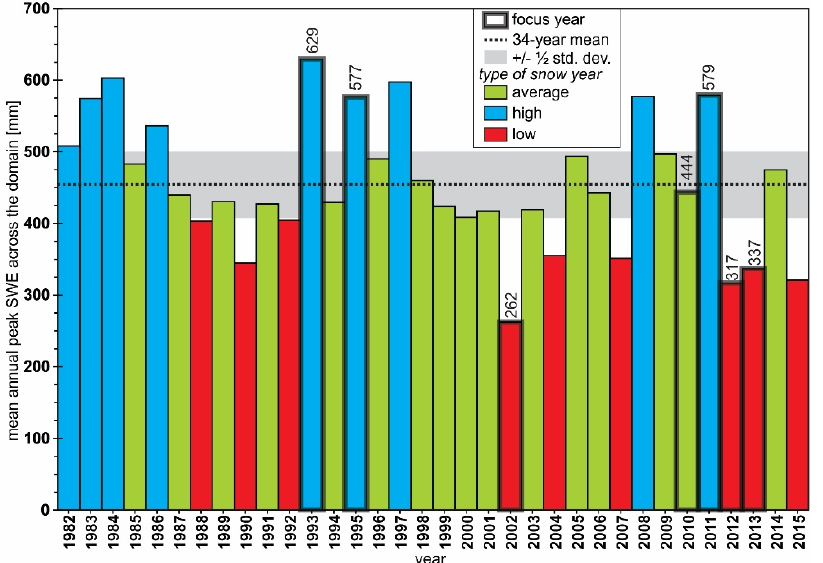
Figure 2. Mean annual peak SWE across the entire domain highlighting the above average (blue), average (green), and below average (red) snow years. The seven characteristic snow years that were used to assess the regression model are identified by the bold outline and peak SWE is labeled (above average: 1993, 1995, 2011; average: 2010; below average: 2002, 2012, 2013).